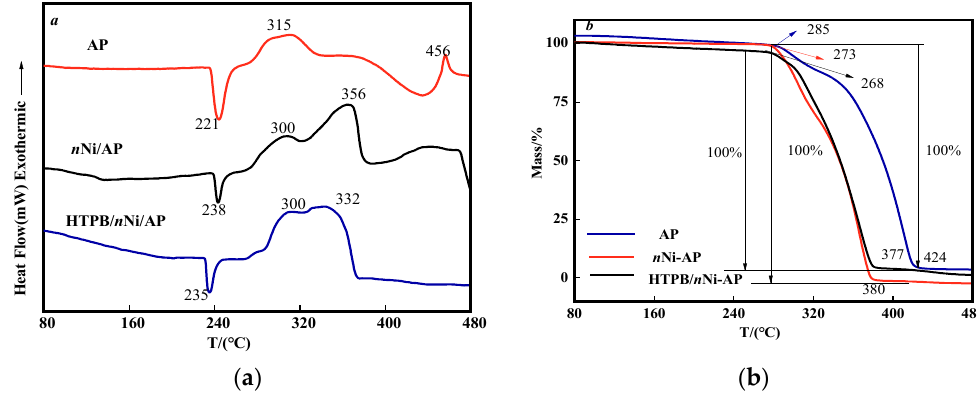
Figure 8. DSC ( a ) and TG ( b ) curves of AP. Figure 8a is the DSC curve of AP, nNi/AP and HTPB/nNi/AP, respectively. It can be